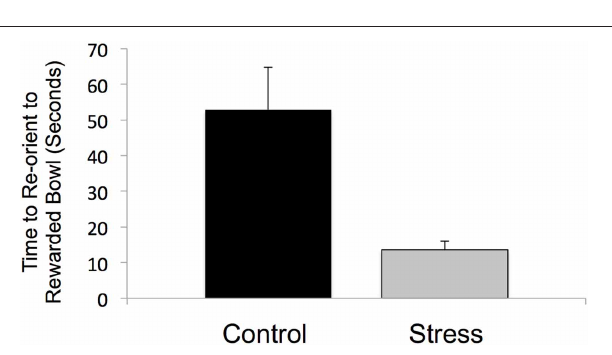
FIGURE 7 | Latency to move to the correct, rewarded bowl after the first incorrect choice. At the first encounter with the unrewarded bowl during cognitive bias training, prior to associative learning, animals that experienced stress during adolescence had a shorter latency to correct their choice and reorient to the rewarded bowl.